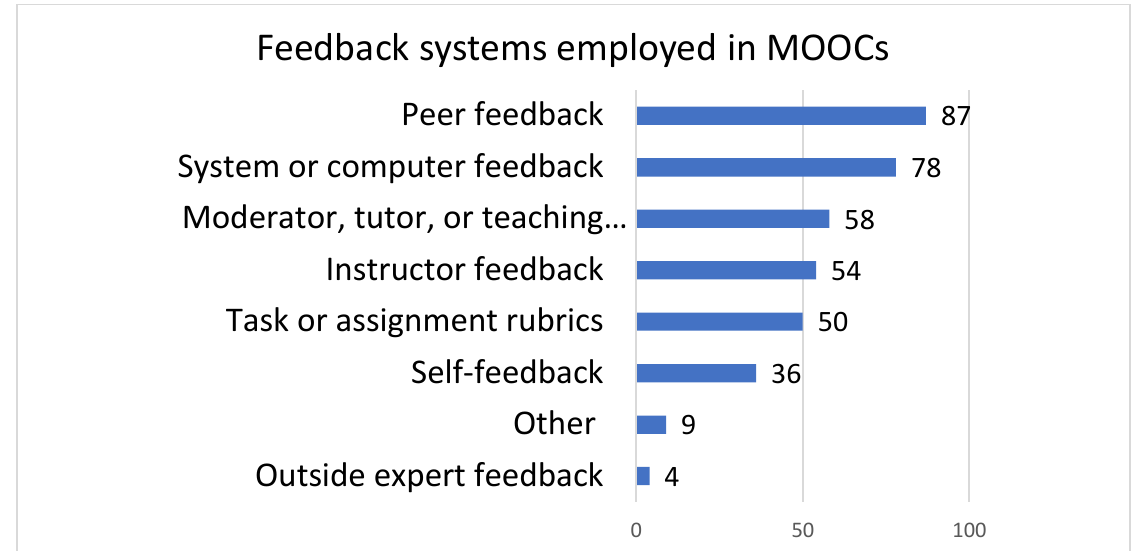
Figure 5 . Number of MOOCs that offer different types of learner feedback